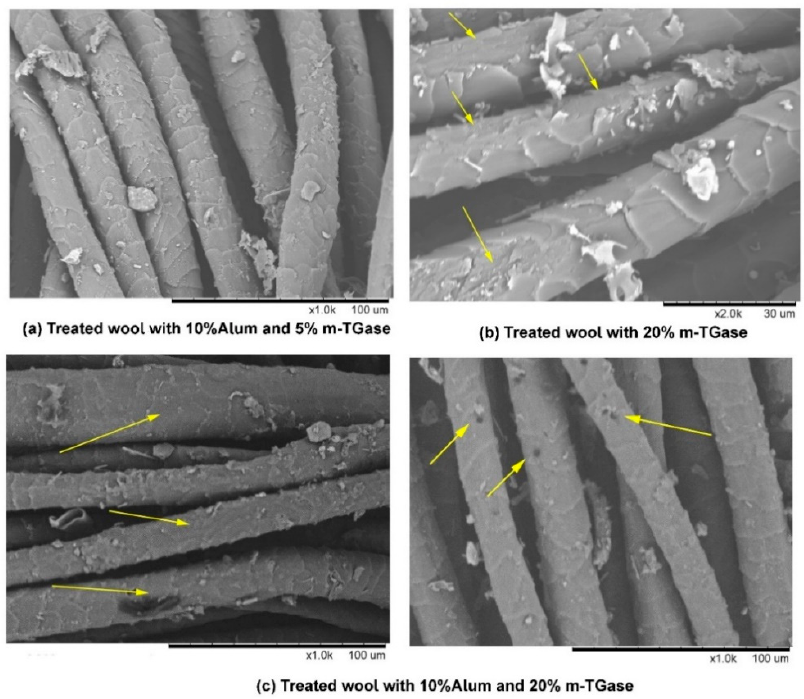
Figure 2. SEM images of treated wool with ( a ) 10% alum-5% m-TGase, ( b ) 20% m-TGase, and ( c ) 10% alum-20% m-TGase; using more m-TGase caused surface damages on wool fiber.